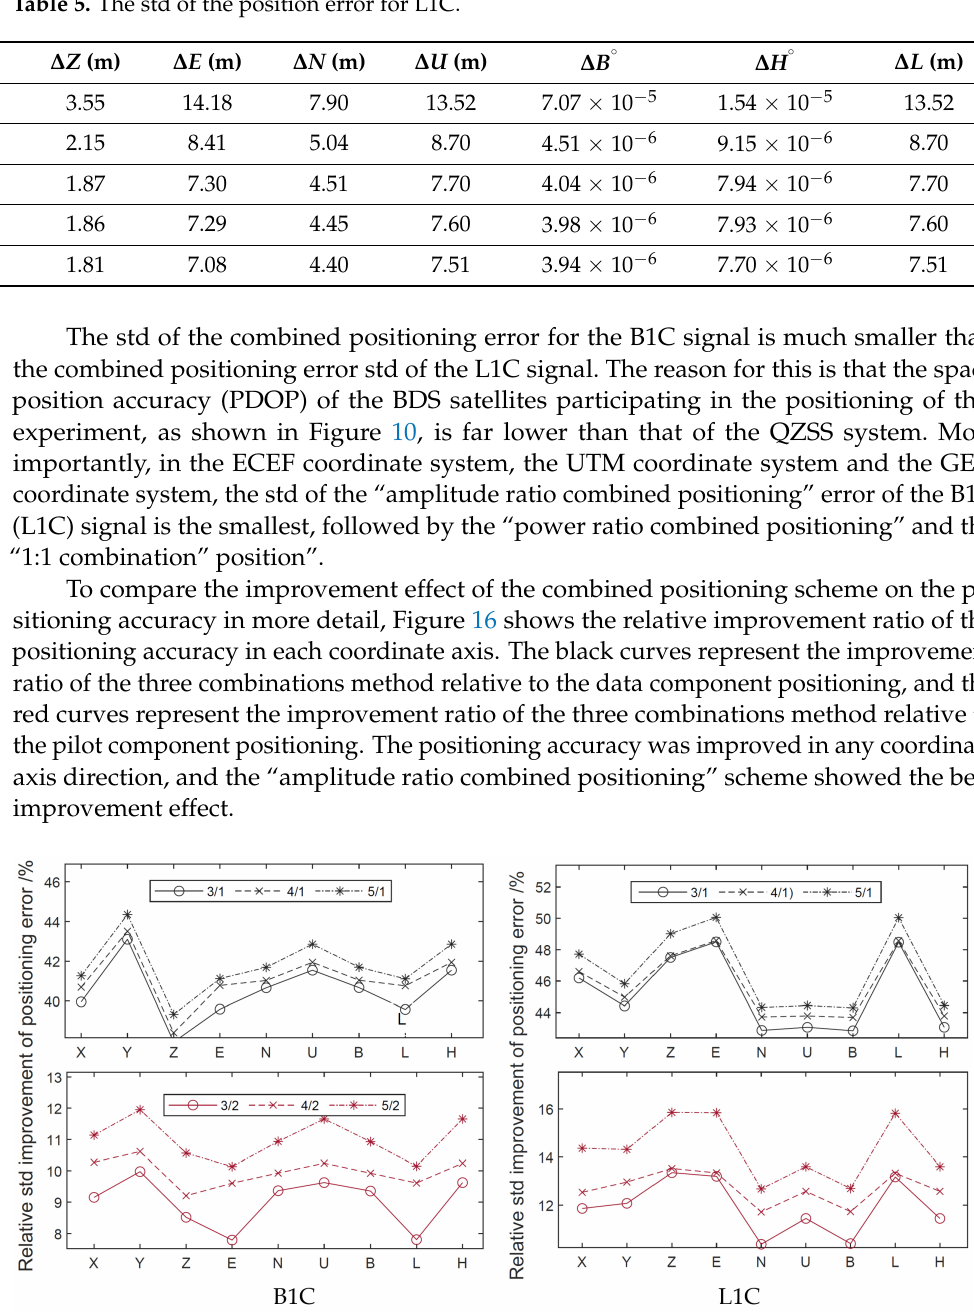
Table 5. The std of the position error for L1C.